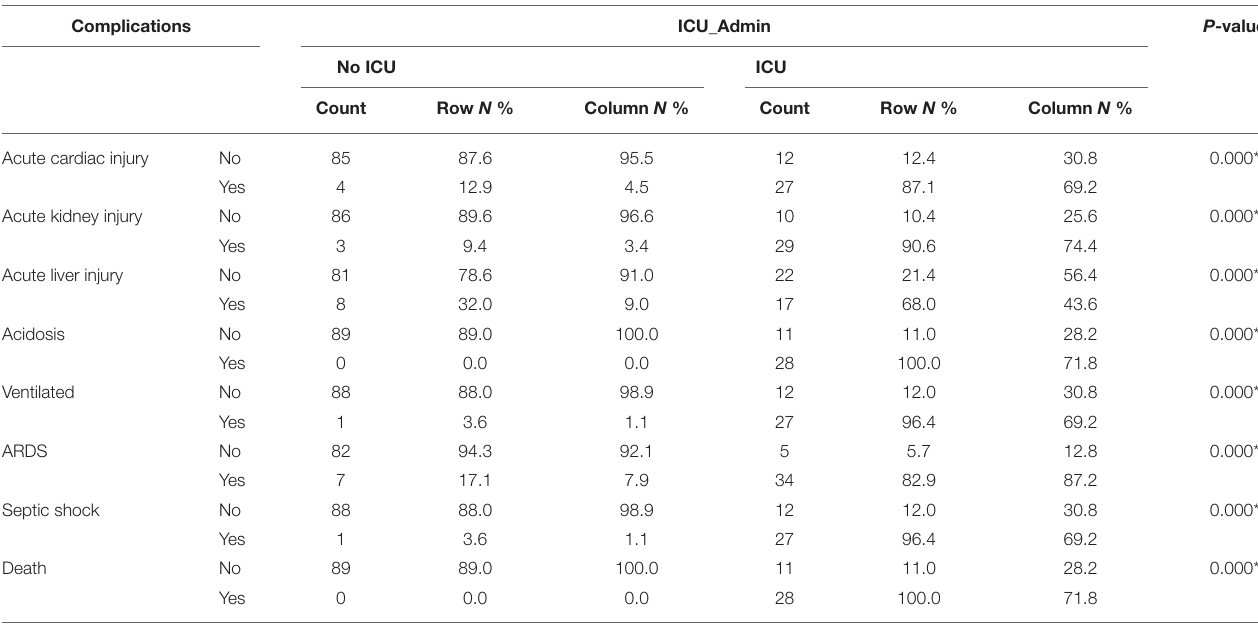
TABLE 6 | In-hospital complication developed in the training